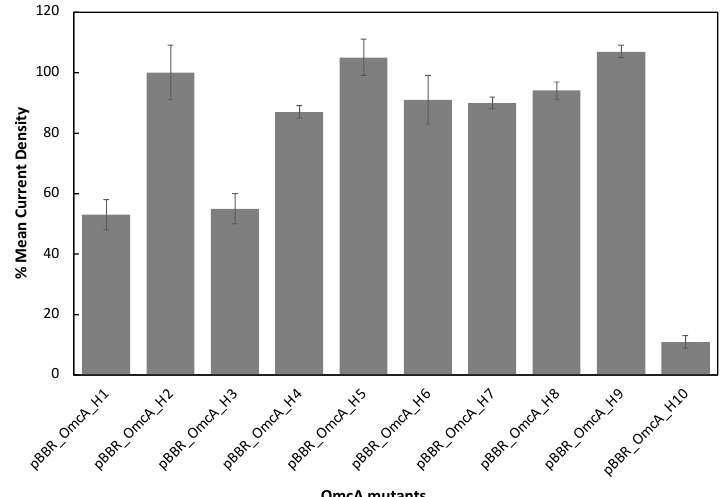
Figure 5. Percentage of the mean current density production of the SOMR1 ∆ OmcA ∆ MtrC carrying mutants of OmcA: SOMR1 ∆ OmcA ∆ MtrC /pBBR_OmcA_H1-10, native OmcA: SOMR1 ∆ OmcA ∆ MtrC/pBBR_OmcA, and the empty plasmid: SOMR1 ∆ OmcA ∆ MtrC/pBBR_empty. These values were determined using the data obtained by SOMR1 ∆ OmcA ∆ MtrC/pBBR_OmcA and SOMR1 ∆ OmcA ∆ MtrC/pBBR_empty as the maximum and minimum current references, respectively.